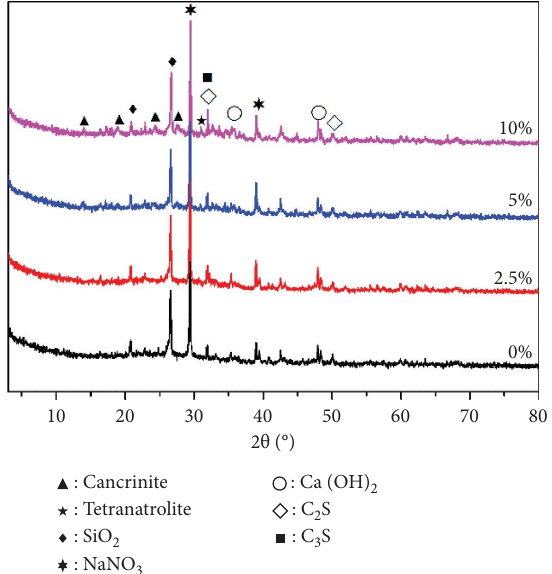
Figure 4: Te XRD patterns of SFCM with diferent sodium hy- droxide contents after curing at 20 ° C for